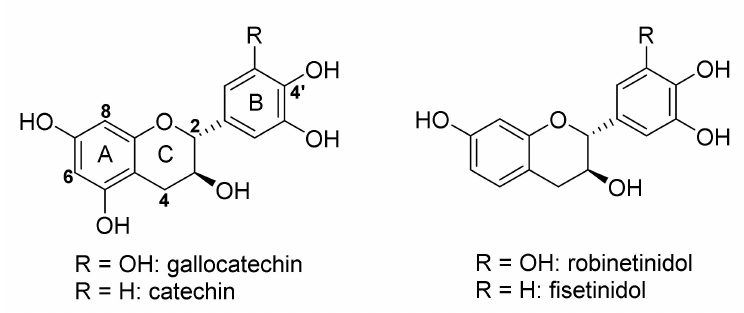
Figure 2. Flavan-3-ol monomers isolated from Acacia mearnsii De Wild. bark.